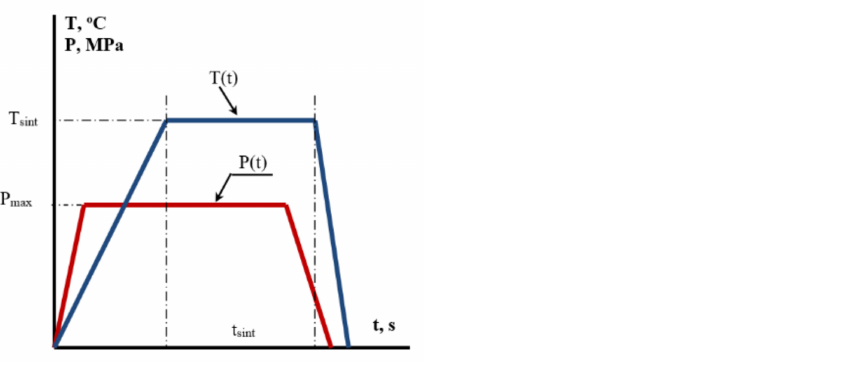
Figure 1. Schematic representation of sintering regimes for α -WC+10 wt.%Co